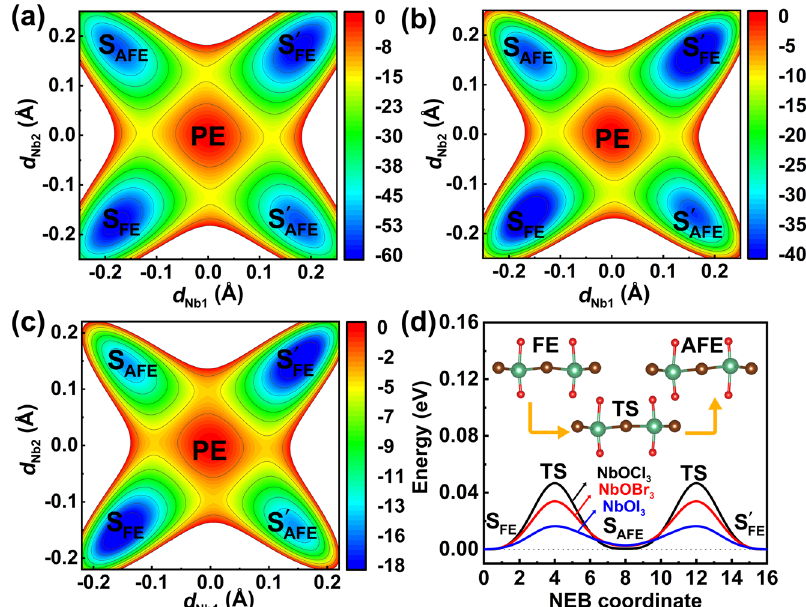
Fig. 2 Energy map and NEB results. a – c The energy contour plot (in meV) of the 1D NbOX 3 unit cell as a function of the polar displacements of two Nb ions for NbOCl 3 , NbOBr 3 , and NbOI 3 , respectively. The energy of the PE phases is set to zero. d Energy pro fi les along the NEB pathway for the polarization switching of 1D FE NbOX 3 . The inset shows the structure evolution from FE to AFE states through the transition state